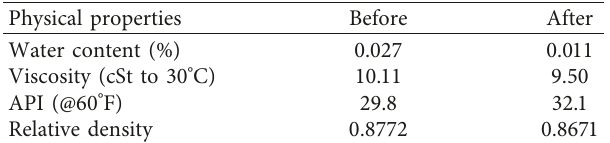
Table 1: Properties of the light oil used before and after injection of DMCHA in sand-pack